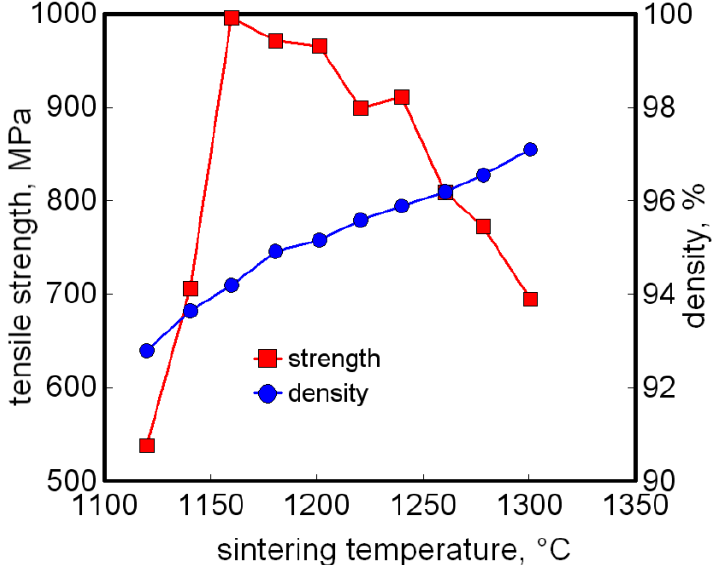
Figure 4. Sintered density and tensile strength for Ti-12Mo versus the sintering temperature